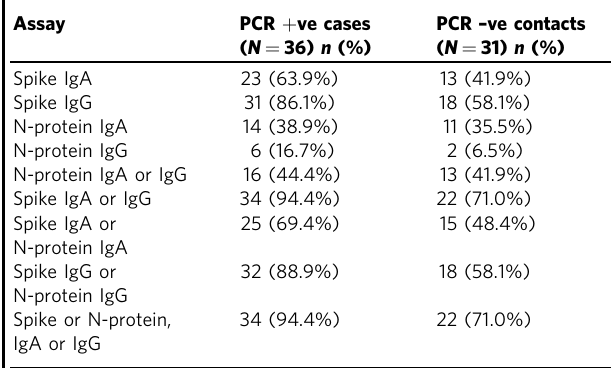
Table 3 Detection of salivary antibody in household